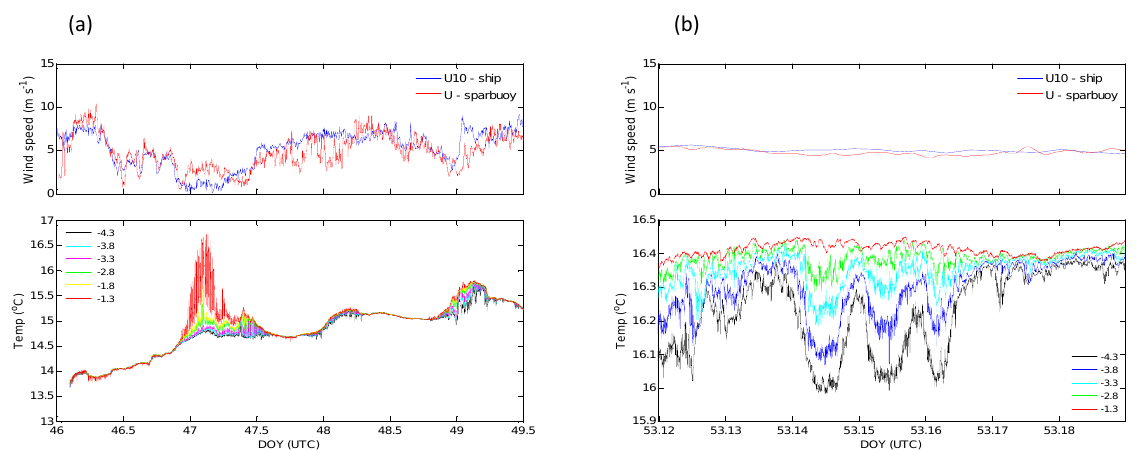
Figure 8. Wind speed (upper) and subsurface temperature structure measured by the spar buoy (lower) (a) under calm atmospheric conditions on DOY 47 (following Walker et al., 2016) and (b) during stable atmospheric conditions with downward heat flux on DOY 53. Indications of internal wave activity (period 12min) are centred at 53.15. Depths of temperature measurements (m) are shown on the